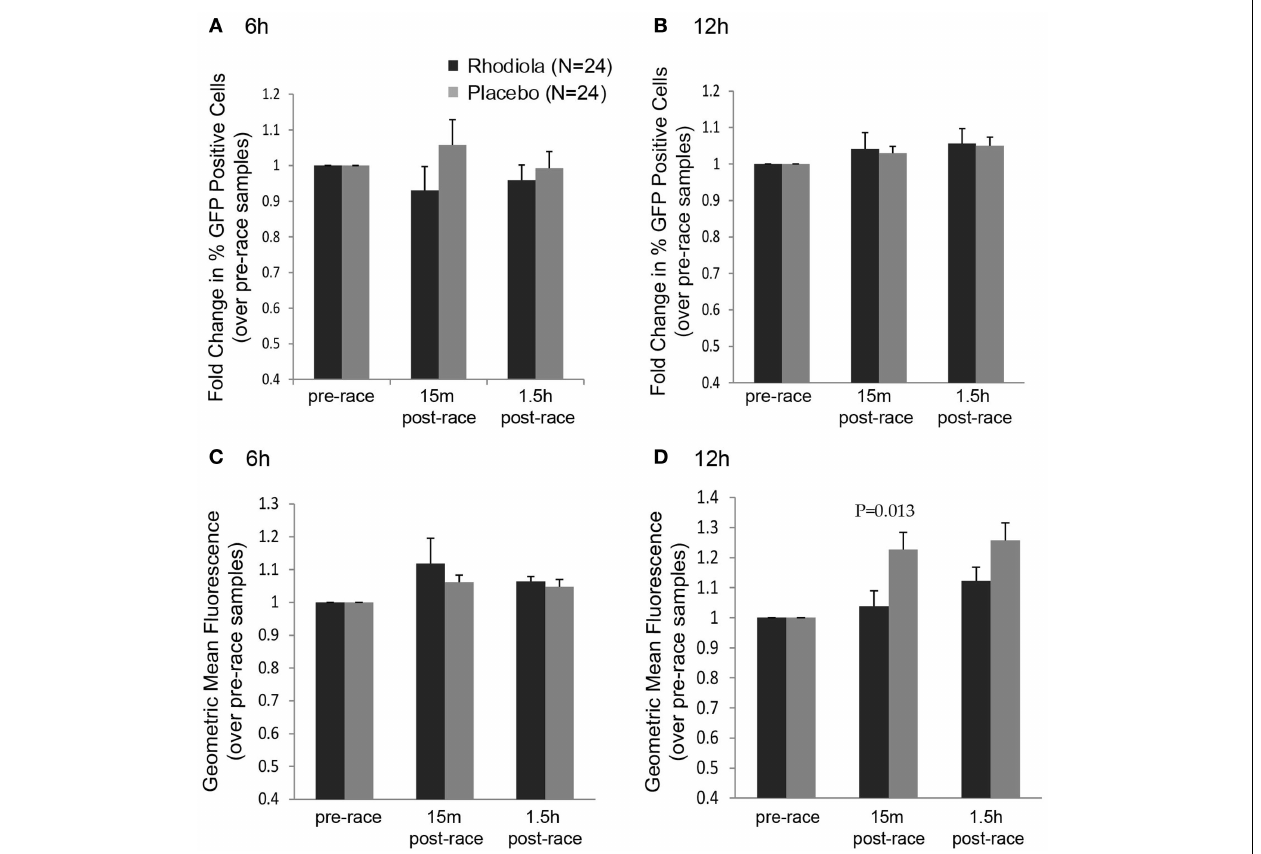
FIGURE 3 | Replication of VSV in HeLa cells in the presence of serum from Rhodiola rosea or placebo-supplemented subjects . HeLa cells were incubated with serum from Rhodiola rosea or placebo subjects for 4h and infected with rwt-GFP virus. At 6 or 12h post-infection, GFP expression was measured by flow cytometry. Data were expressed as the percentage of cells